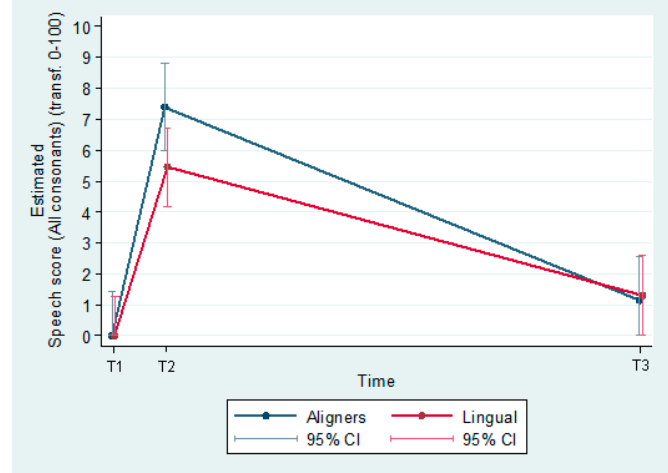
Figure 7. Speech articulation.